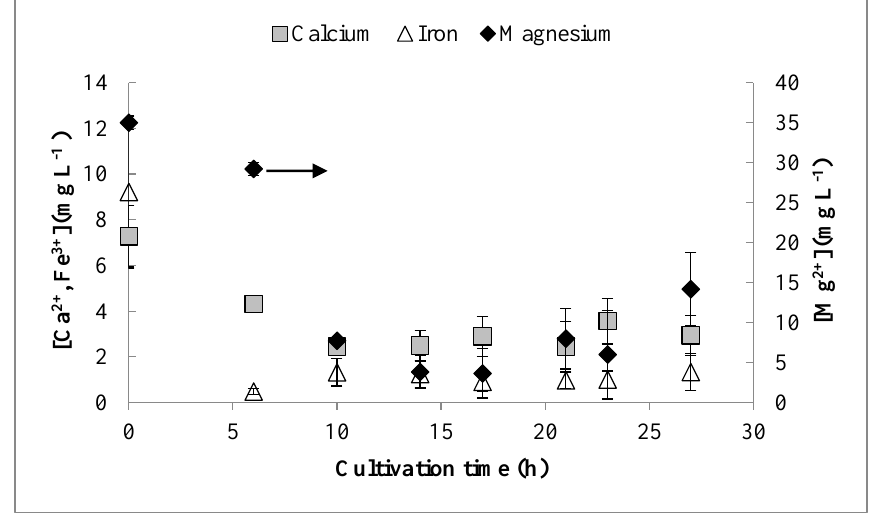
Figure 2. Analysis of residual concentrations of trace elements (calcium, iron, magnesium) in the culture supernatant by inductively coupled plasma optical emission spectrophotometer (ICP-OES). Error bars represent standard deviations between three biological replicates.